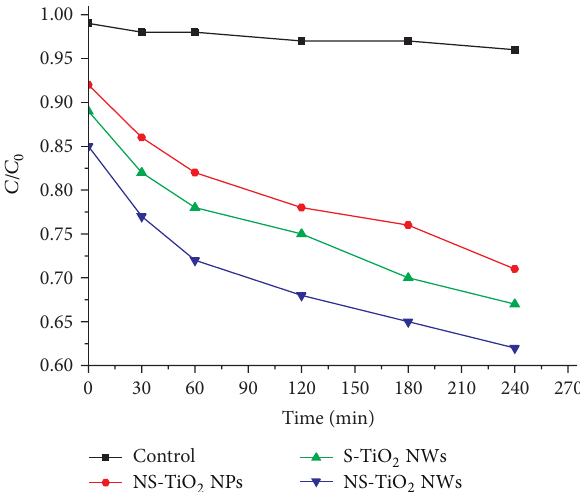
Figure 11: The variation in the concentration of NBT with NS-TiO 2 NPs, S-TiO 2 NWs, and NS-TiO 2 NWs samples under visible light irradiation.